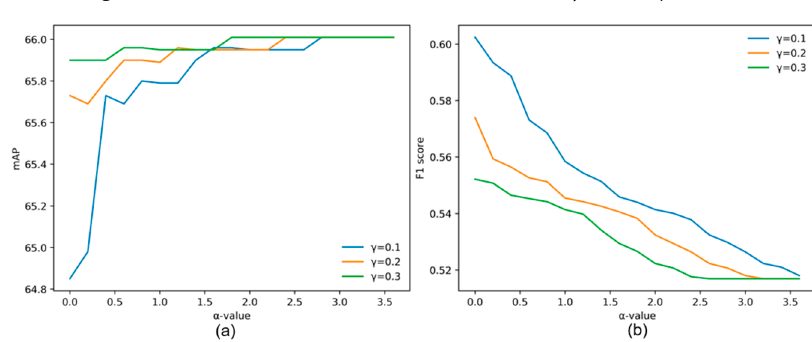
Figure 9. Trend of the removal rate with different β , α and γ values.